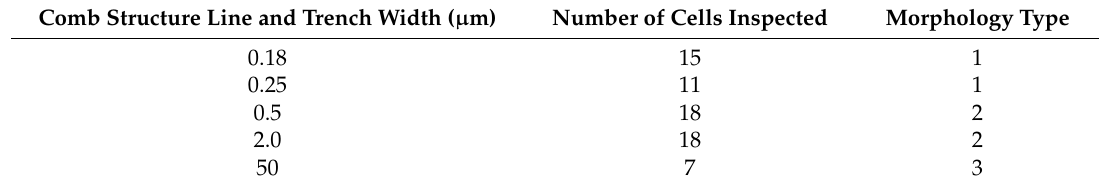
Table 1. Number of cells inspected in each comb structure and the corresponding type of morphology. Comb Structure Line and Trench Width ( µ m)